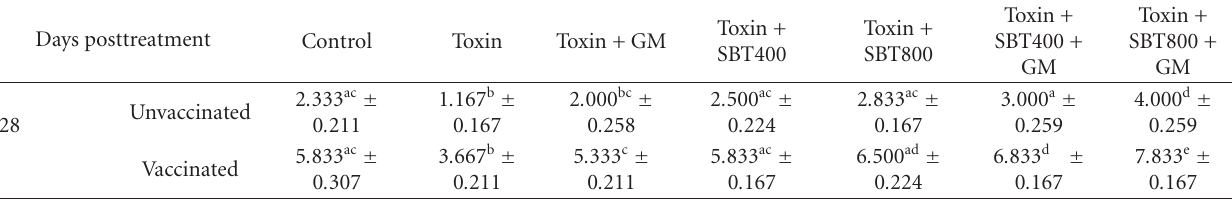
Table 1: E ff ect of dietary supplementation of seabuckthorn berries (SBT) and glucomannan (GM, mycotoxin binder) on haemagglutination inhibition titres (log 2 values) in birds fed with T-2 toxin.